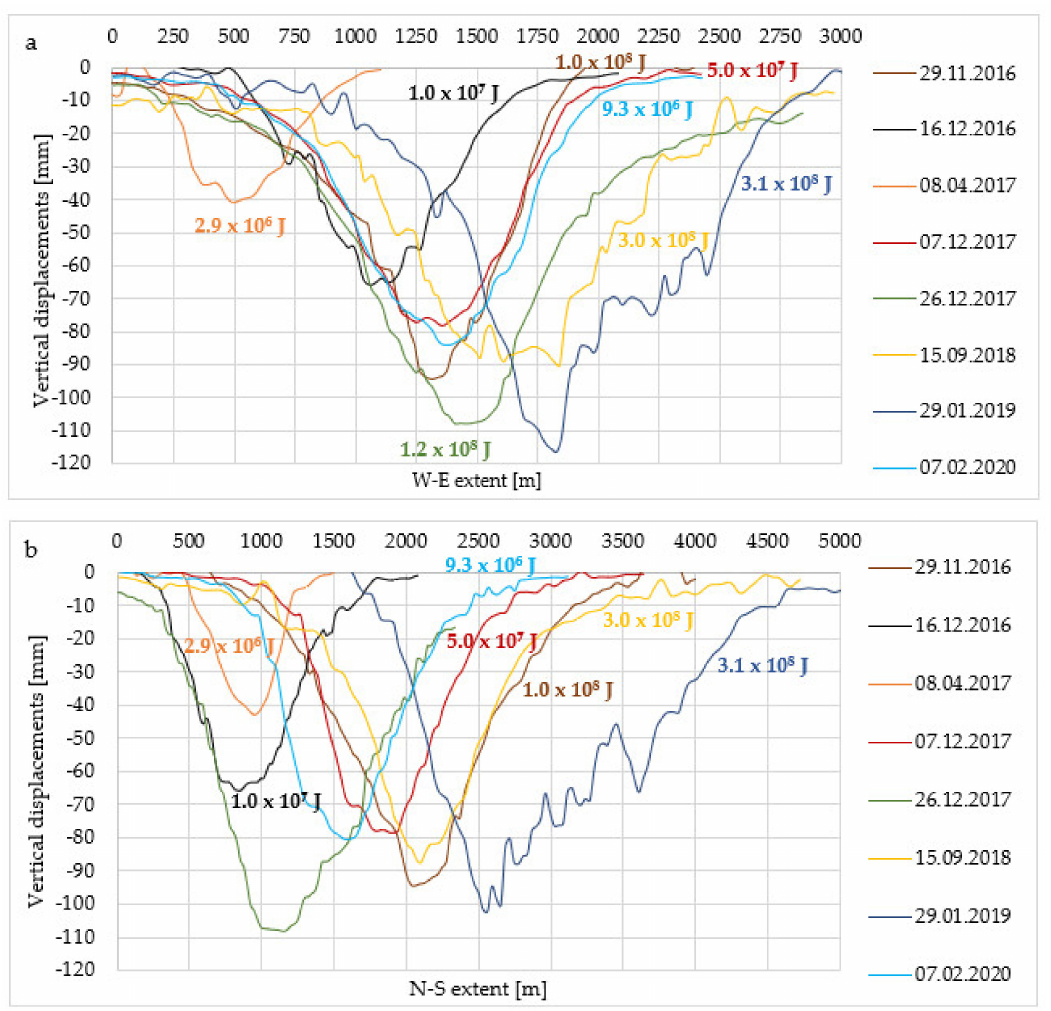
Figure 7. Profiles of troughs formed by eight induced shocks (mean value of spatial extent vs. mean value vertical displacements). ( a ) Profiles towards the W–E. ( b ) Profiles towards the